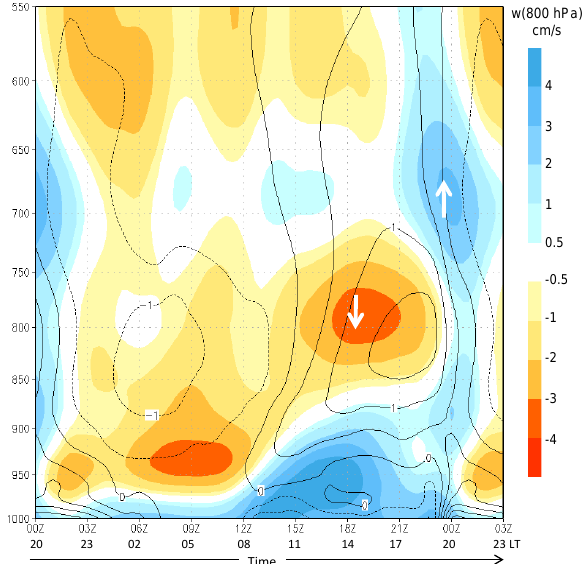
Fig. 10. Diurnal cycle of the vertical velocity (colors, in cms − 1 ) and air temperature anomalies (contours: positive solid, negative dashed) with pressure at the coastal column P (see location in Fig. 8) averaged between 19–22 ◦ S and over the 4-day run. Cold colors indicate ascent, warm colors indicate subsidence. For display pur- poses, part of the mean diurnal cycle is repeated.